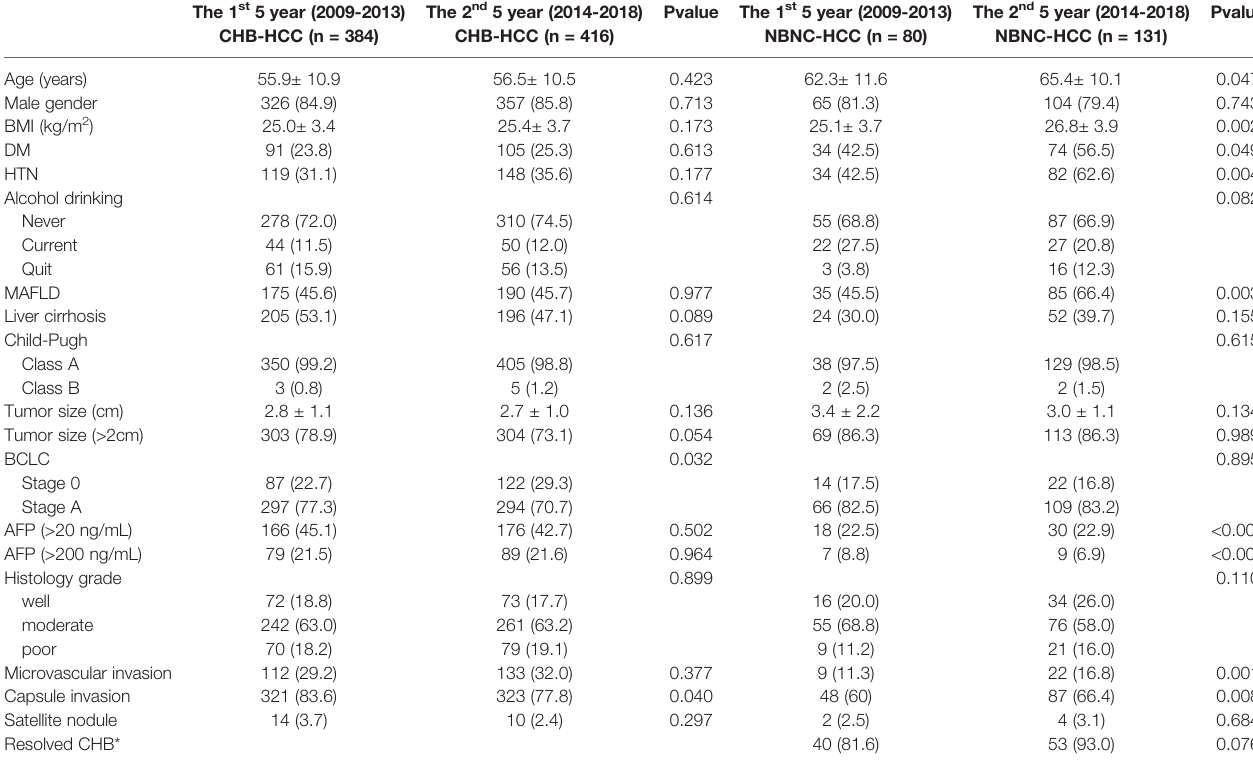
TABLE 2 | Comparison of the clinicopathologic characteristics of the CHB-HCC and NBNC-HCC patients from the fi rst 5 year (2009-2013) to the 2 nd 5 year